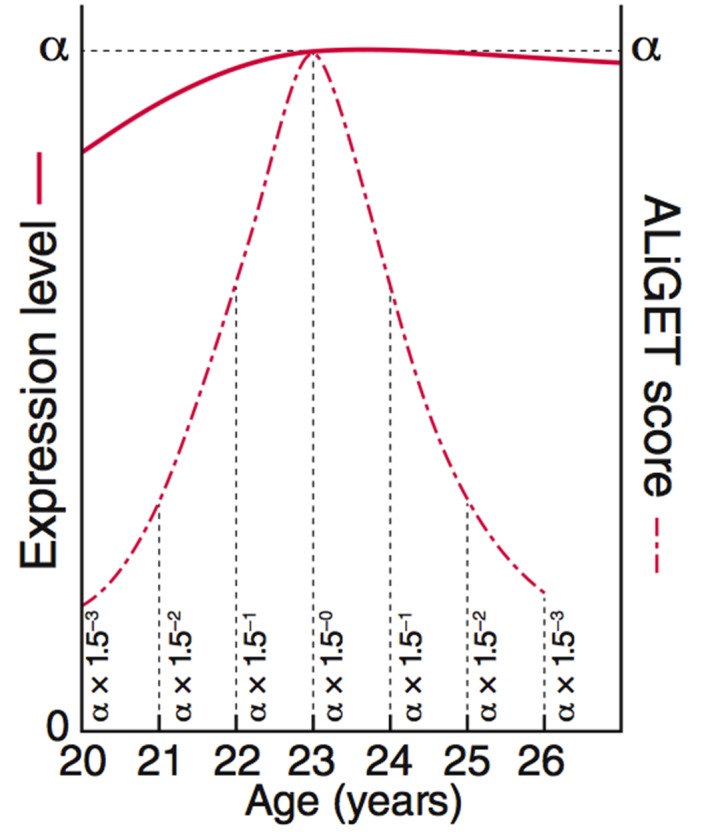
ALiGeT scoring assigns a score to each gene for each year of age.The value decays further with increasing distance from the year at which the turning point occurs. This diagram shows the equations and graphs for how the scores (dashed red line) decay for a specific example trajectory (solid red line).